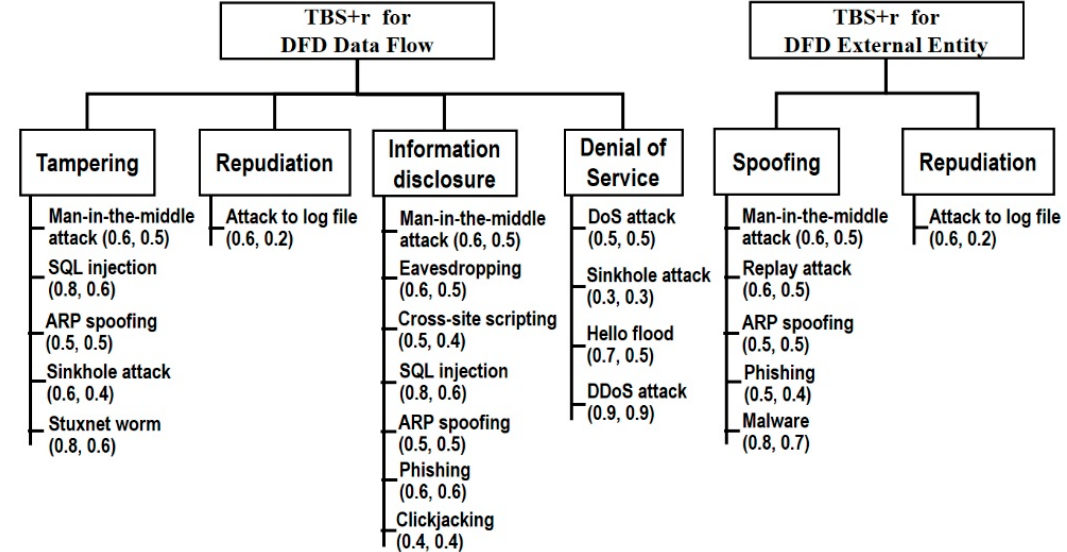
Figure 4. The TBS+r for DFD Data Flow and DFD External Entity, respectively. Figure 4. The TBS + r for DFD Data Flow and DFD External Entity,